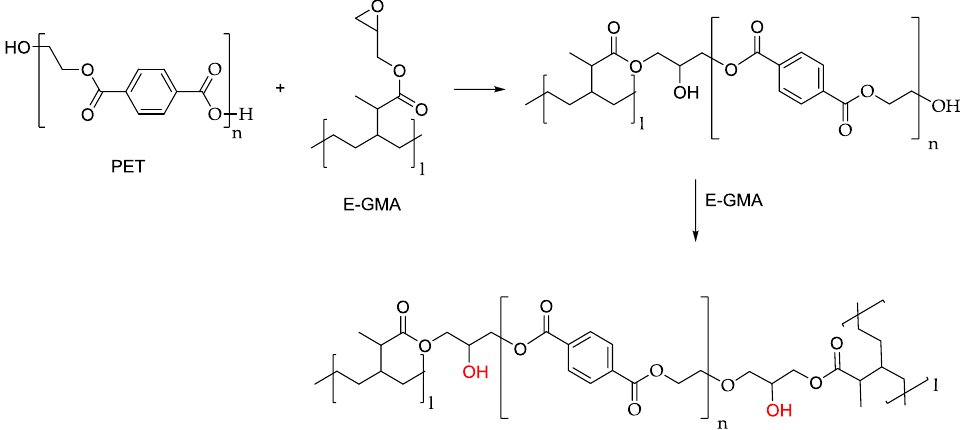
Figure 6. Cross-linking mechanism of E-GMA with PET. The hydroxyl groups marked in red show possible reaction sites for further cross-linking reactions. Adapted from [94].